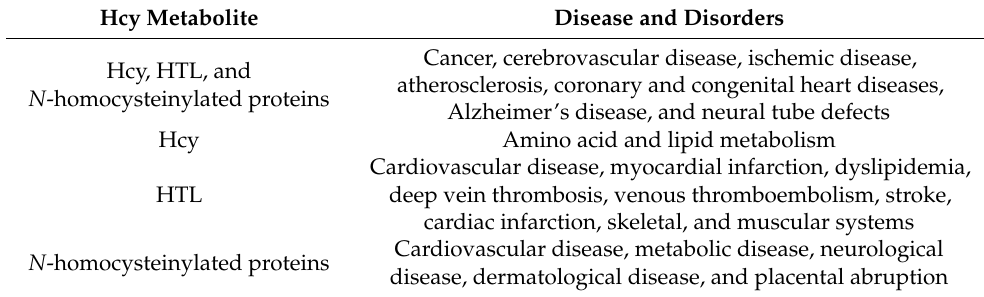
Table 1. Diseases and disorders are mostly associated with Hcy metabolites according to work